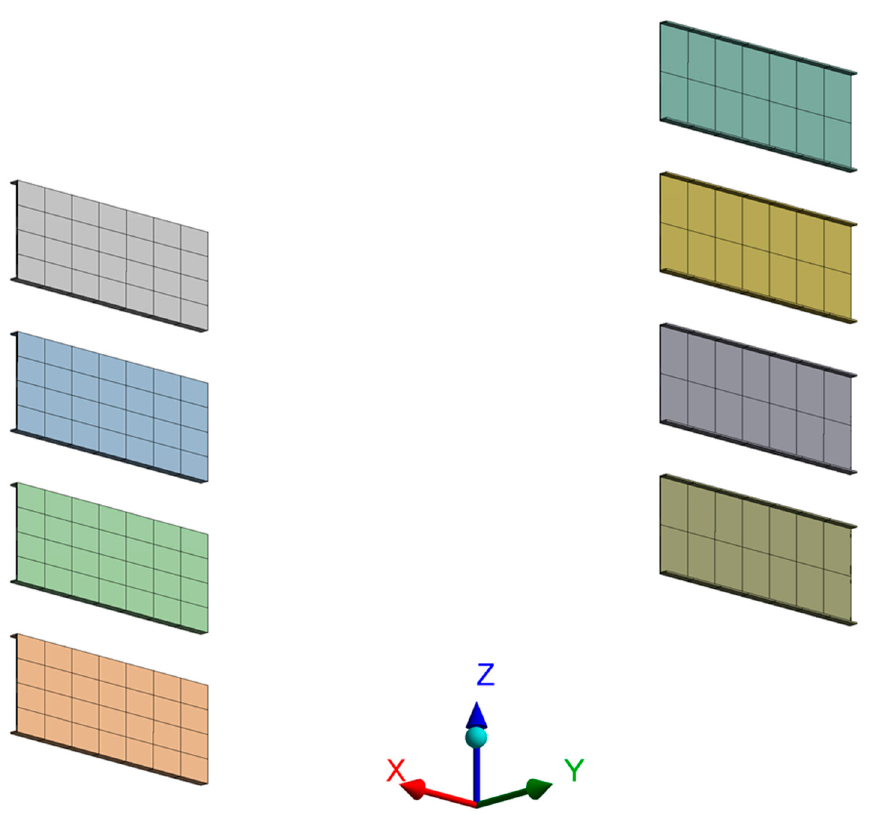
Figure 10. Reduced Vibration Sensor Location Candidate.